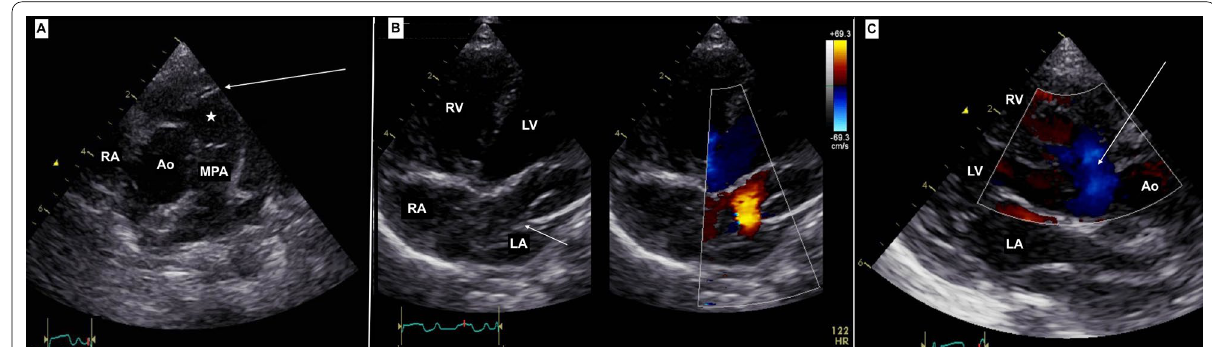
Fig. 1 Transthoracic echocardiography. A Parasternal short axis view showing the hypertrophied muscle bands (arrow) with distal infundibular chamber (*). B Apical four-chamber view showing the membranous partition in the LA (arrow) with turbulent flow across its aperture. C Parasternal long axis view showing the perimembranous VSD (arrow). (Ao-aorta)